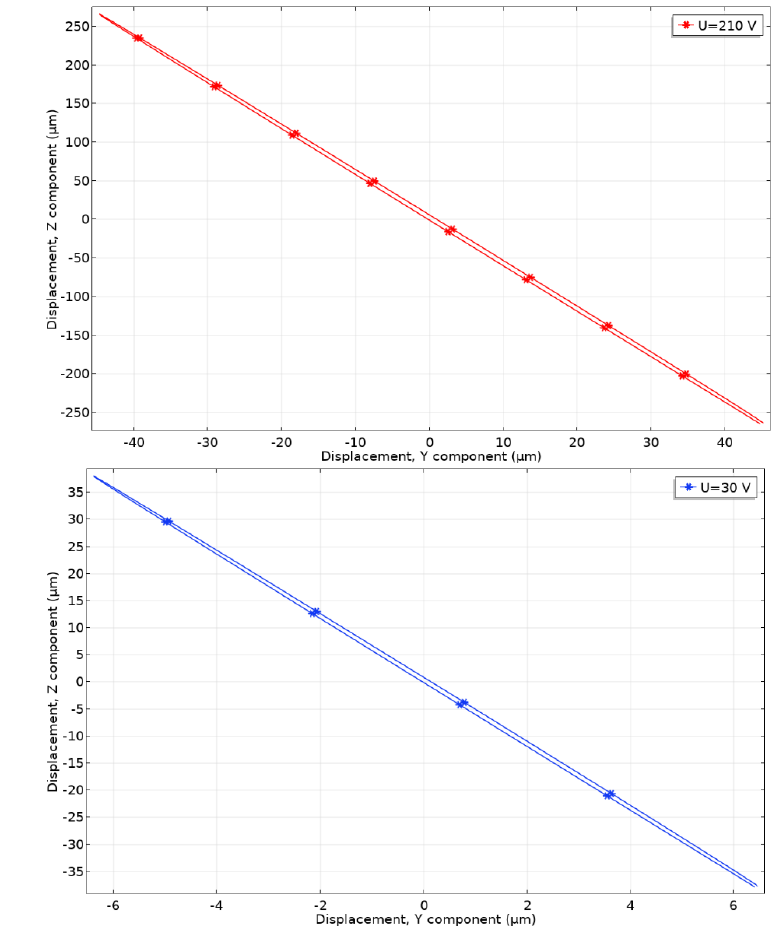
Figure 12. Motion trajectories of contact point located on Plate 1 ; ( a )—motion trajectory at 210 V p-p excitation amplitude; ( b )—motion trajectory at 30 V p-p excitation amplitude. Micromachines 2021 , 12 , 1396